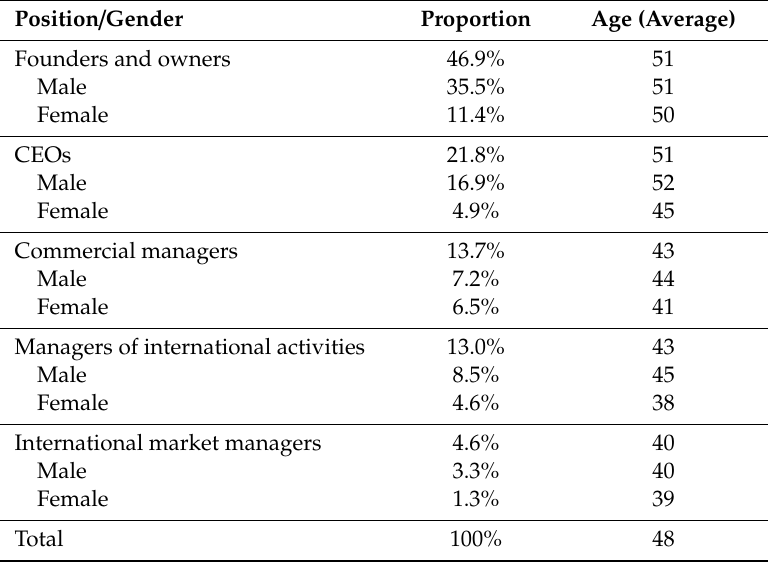
Table 1. Sample analysis (participants’ position, gender, and